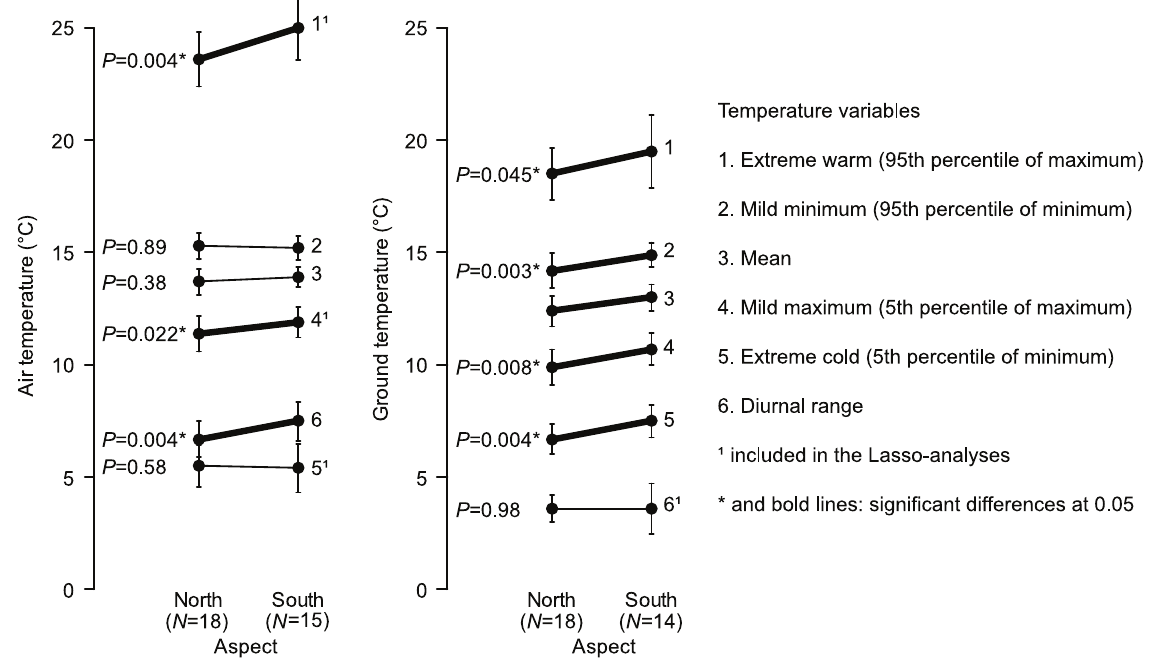
Figure 2. Comparison of ground and air temperatures (mean ± 1 SD) between the north- and south-facing slopes. p-values were derived through Welch’s t-tests.